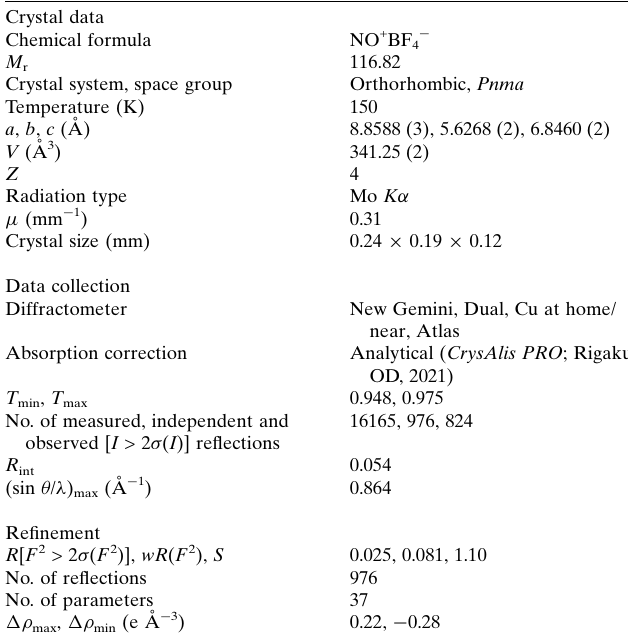
Table 1 Experimental